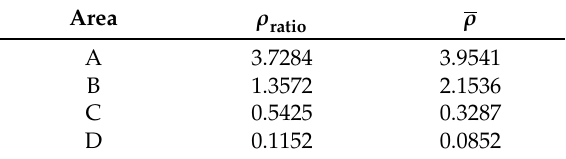
Table 2. Comparison of ρ and ρ in four areas. Values are averaged within each ratio